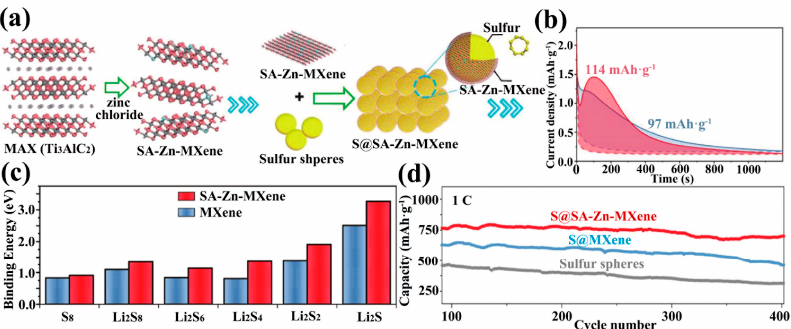
Figure 7. ( a ) Synthesis of SA-Zn-MXene@S cathode. ( b ) Potentiostatic nucleation profiles of Li 2 S 2 /Li 2 S on SA-Zn-MXene and MXene at 2.05 V. ( c ) Binding energies between LiPSs and SA-Zn-MXene layers